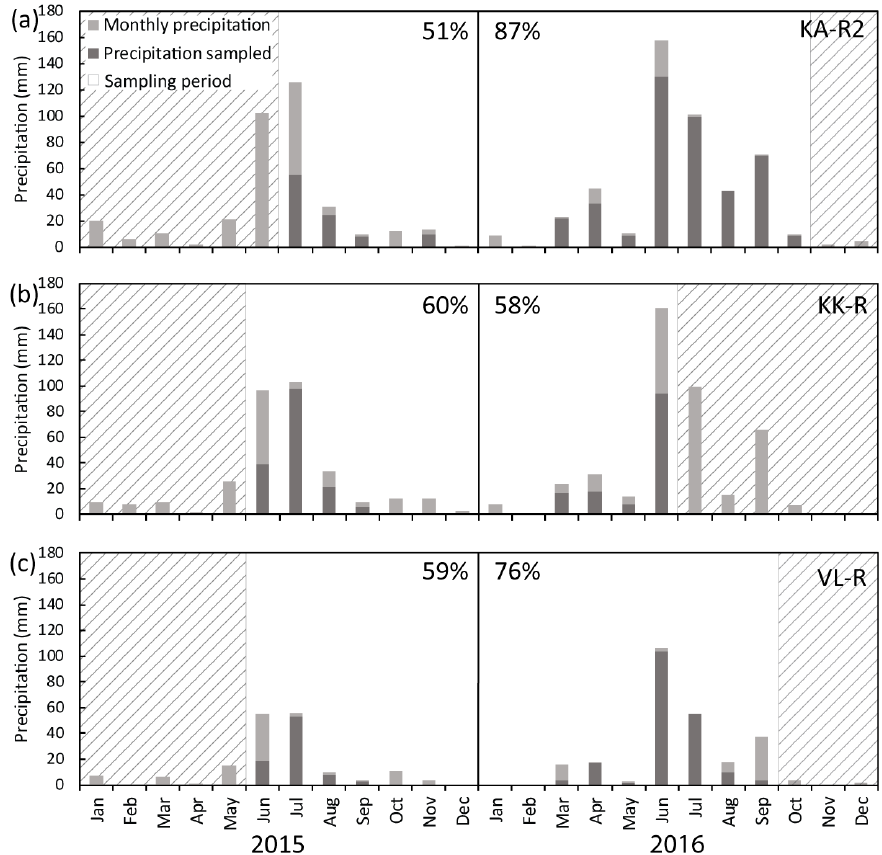
Figure 4. Monthly precipitation values at ( a ) KA-R2, ( b ) KK-R and ( c ) VL-R showing the proportion of precipitation sampled on a monthly basis at the three daily rainfall collectors. Hatching represents the period during which precipitation was not collected. period during which precipitation was not